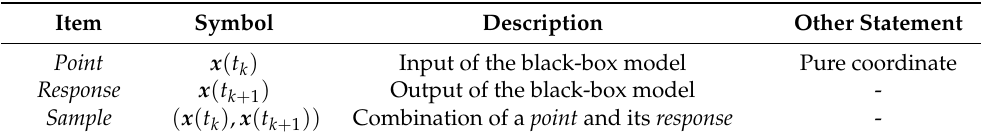
Table 1. Description of point, response and